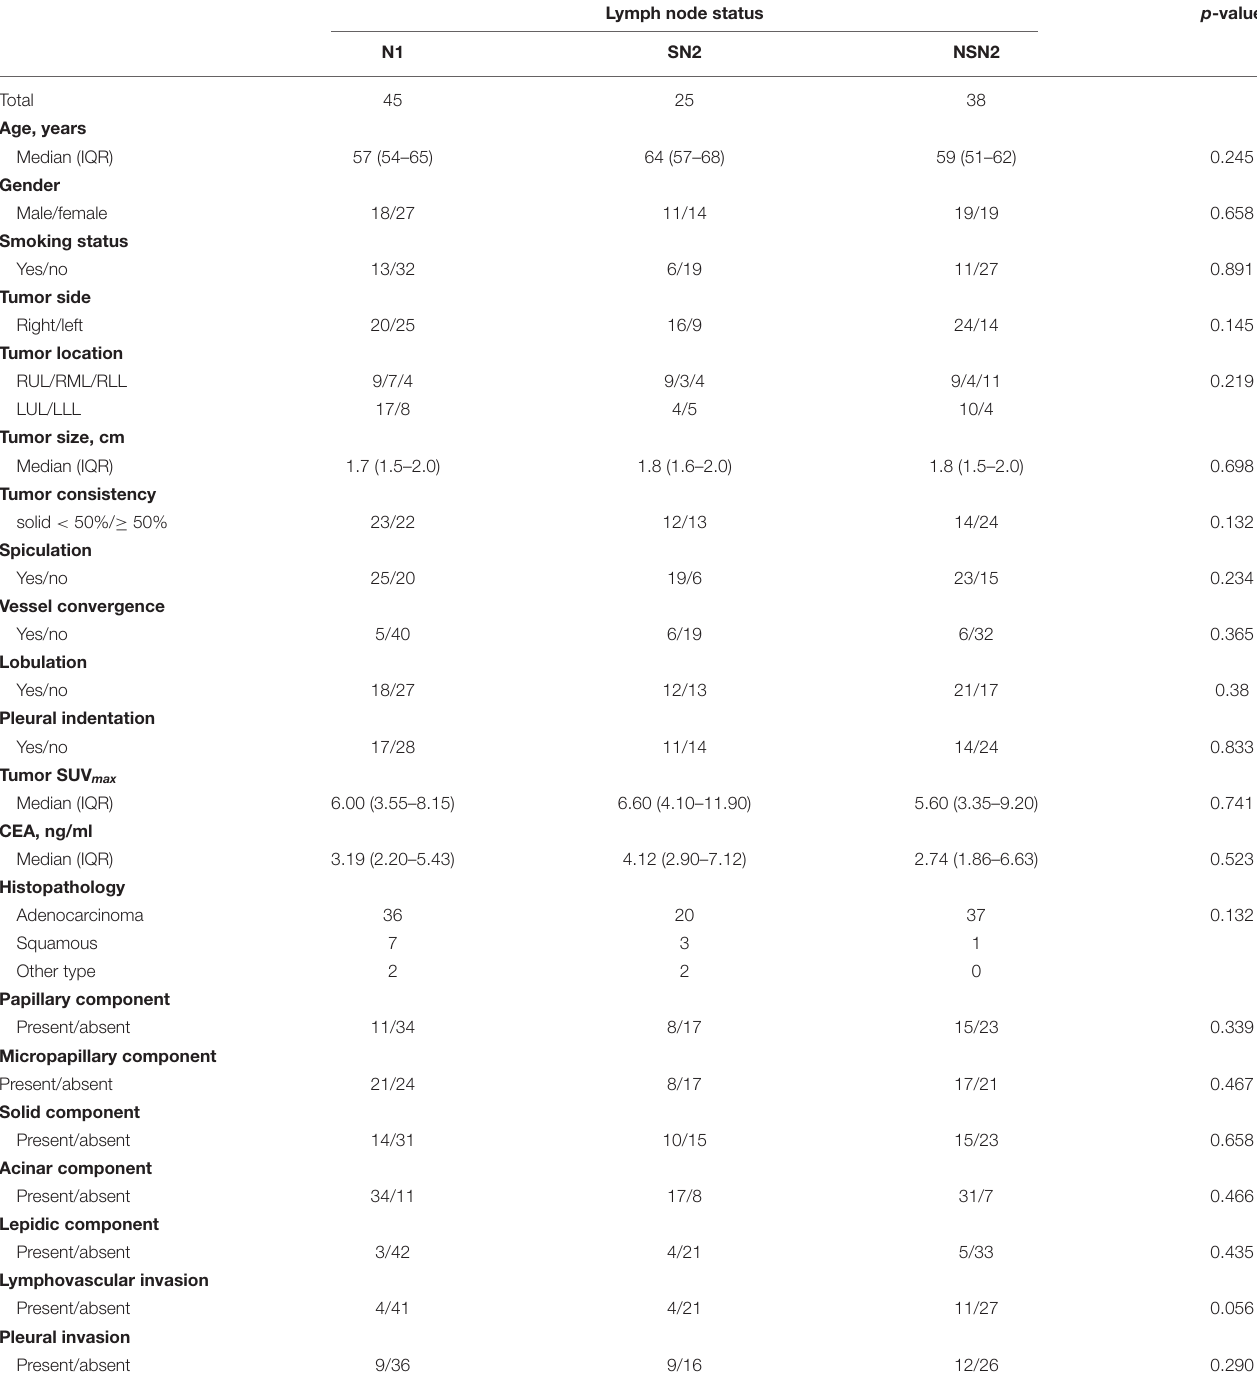
TABLE 3 | Comparison of clinicopathological characteristics among N1, SN2 and